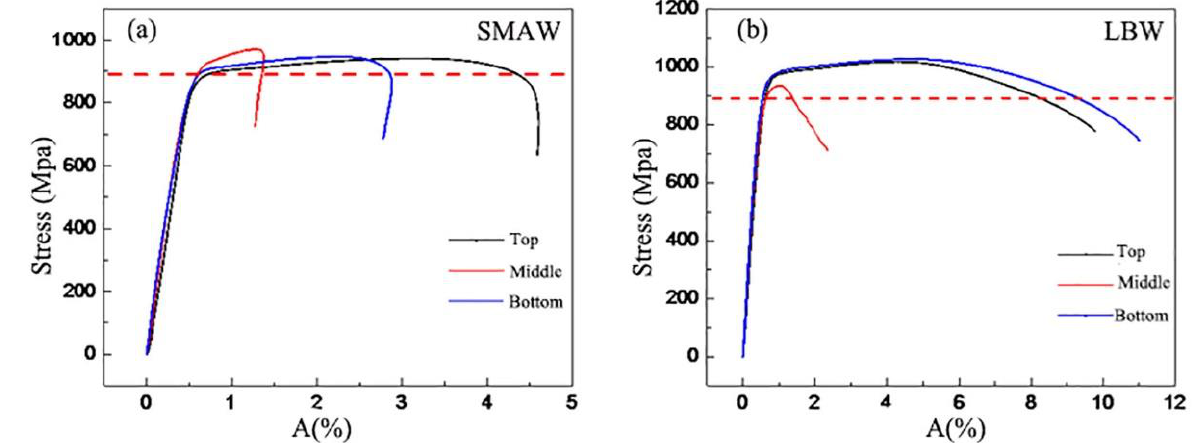
Figure 13. Stress – strain curves of the joints ( a ) the SMAW ( b ) the LBW. Figure 13. Stress–strain curves of the joints ( a ) the SMAW ( b ) the LBW. Table 4. Results of tensile test.